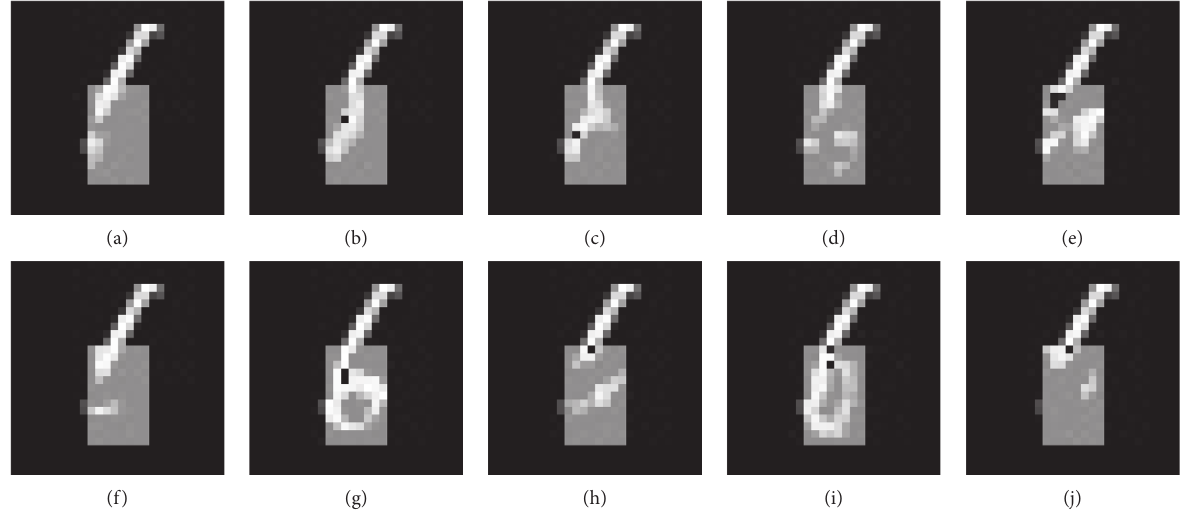
Figure 10: Prediction result by a routing neural network of (a) f training image in X